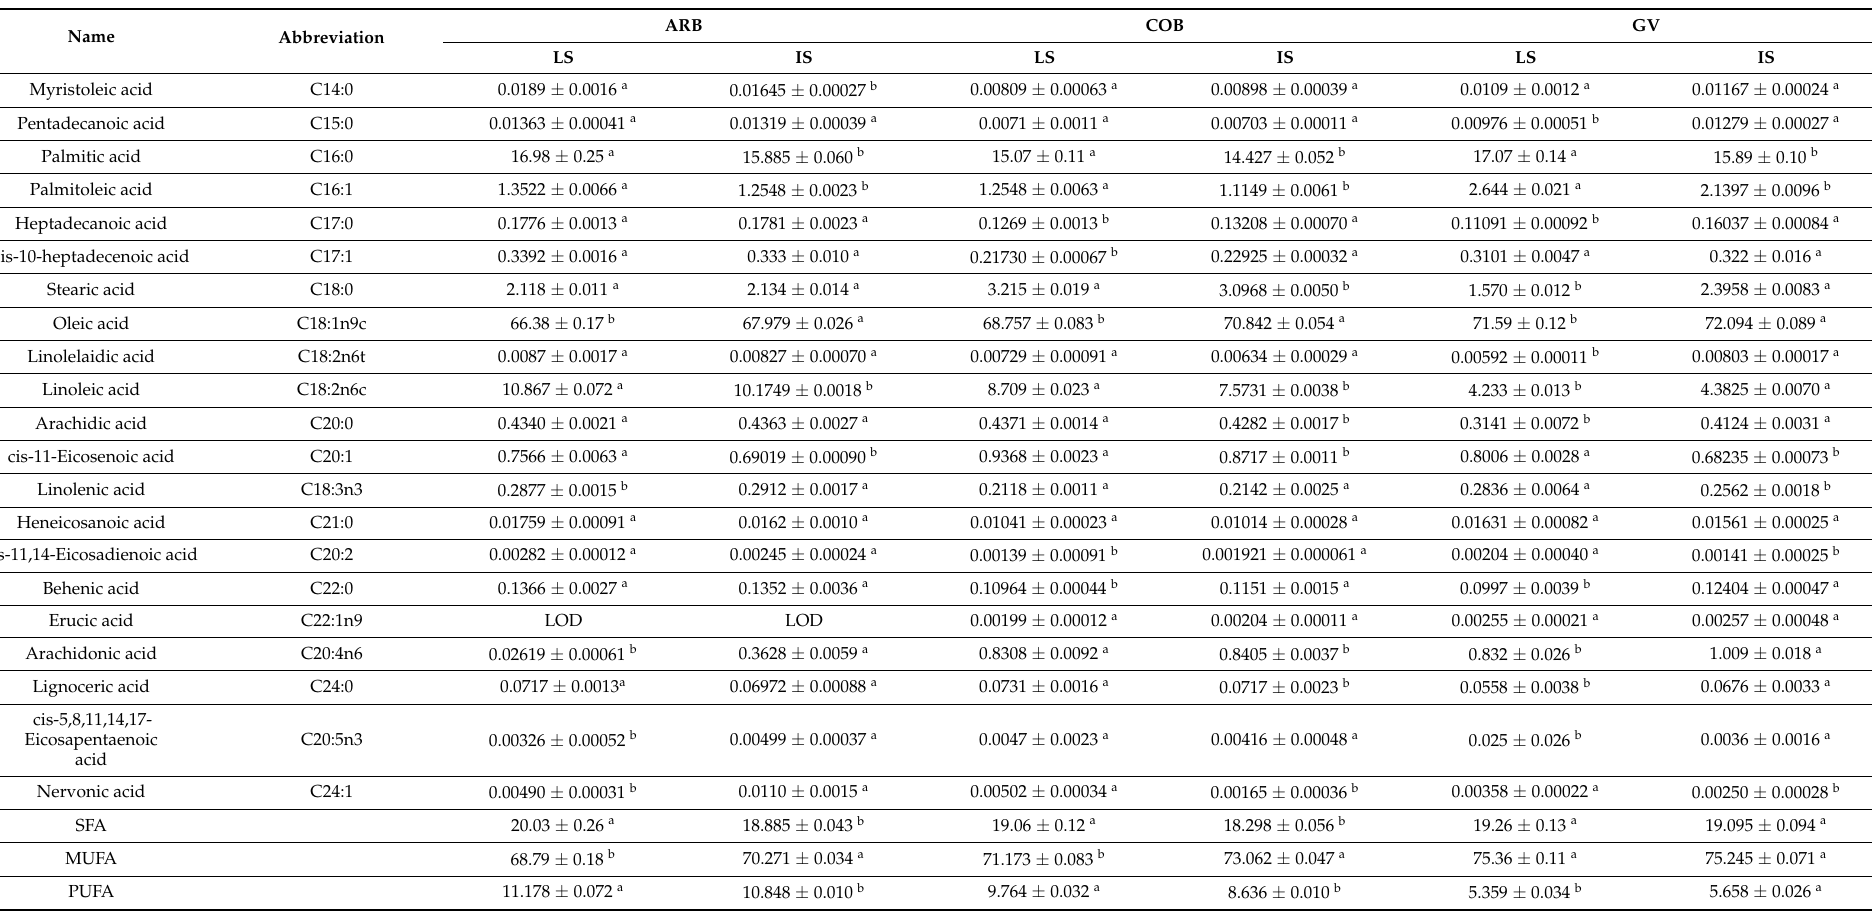
Table 4. Fatty acid composition (%) and total saturated fatty acids (SFA), monounsaturated fatty acids (MUFA) and polyunsaturated fatty acids (PUFA) of olive oils (OO) extracted from both methods, the laboratory scale (LS) and the industrial scale (IS), for the three studied cultivars: ‘Arbequina’ (ARB), ‘Cobrançosa’ (COB) and ‘Galega vulgar’ (GV). Measurements were performed in triplicate and results expressed by mean ± standard deviation. Limit of detection (LOD) was indicated for compounds identified below the detection